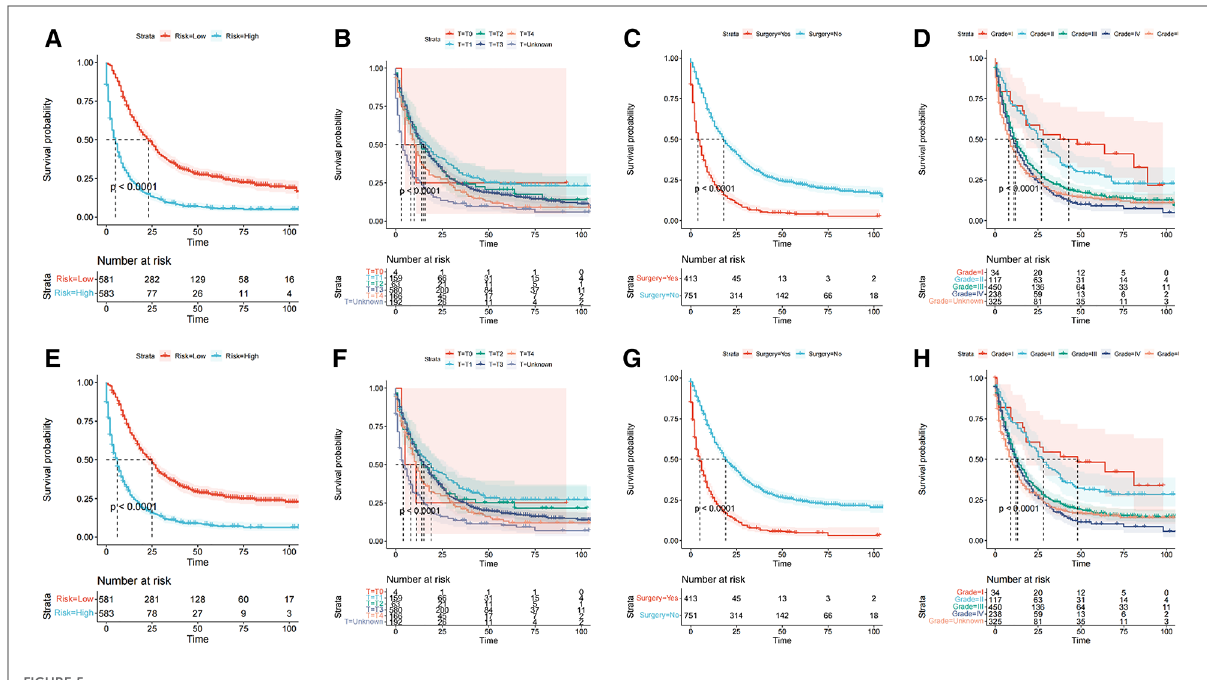
FIGURE 5 The risk strati fi cation system constructed by Kaplan-Meier survival analysis in the validation cohort. ( A – D ) OS; ( E – H )